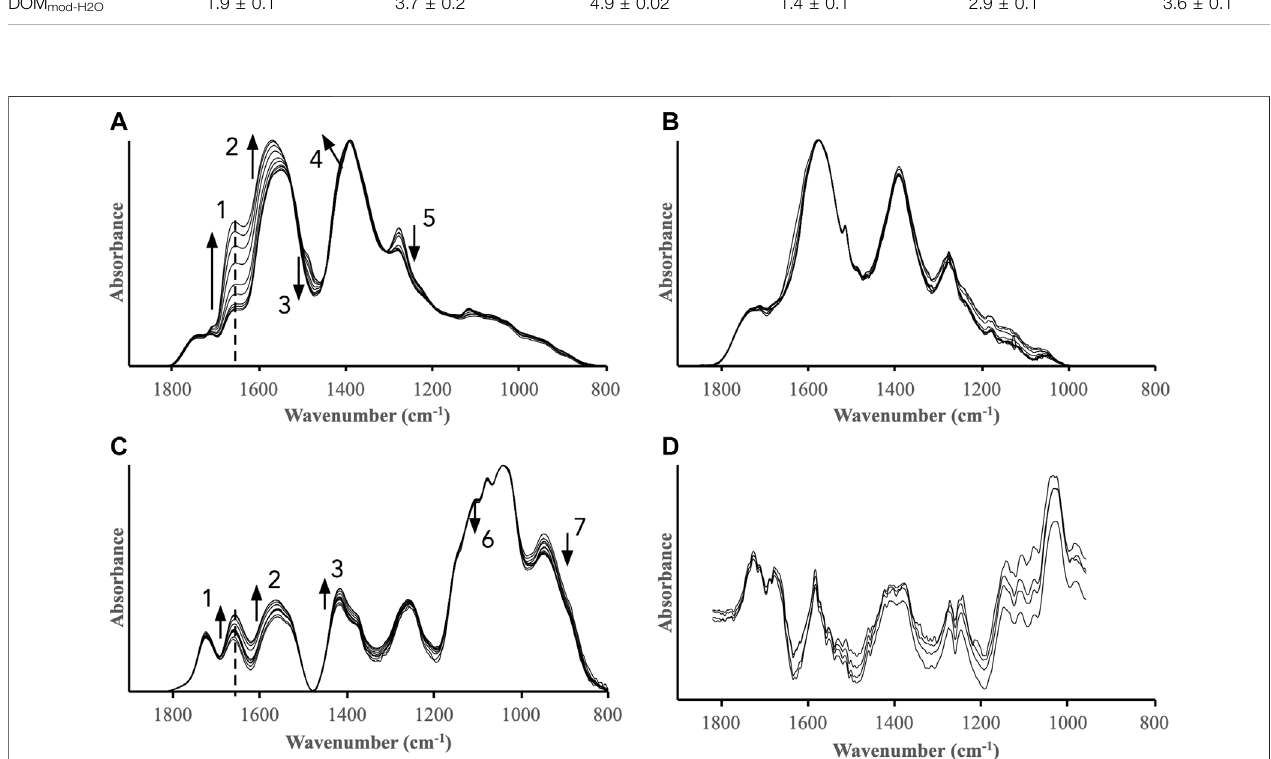
FIGURE 6 | IR spectra of (A) DOM mod-EtOAc-ferrihydrite , (B) DOM mod-EtOAc-goethite , (C) DOM mod-H2O-ferrihydrite , and (D) DOM mod-H2O-goethite after addition of H 2 O 2 . Spectra collected after t = 1 min and t = 1,440 min are included in all sub-plots together with selected spectra in between these times. The H 2 O 2 concentration was 100 μ M and pH was maintained at pH 4.0 with a pH-stat. Note that these experiments were performed in absence of TPA. The dotted lines indicate the 1,660 cm − 1 band, and the arrows indicate the direction of intensity change as a function of time. The bands marked with arrows likely have predominant contributions from: 1) carbonyl-likemodes;2)asymmetriccarboxylstretch;3)aromaticskeletonmode;4)symmetriccarboxylstretch;5)phenolicC-O-Hbend;6)and7)carbohydrateskeleton modes (see Supplementary Table S2 for an overview of the band assignments).